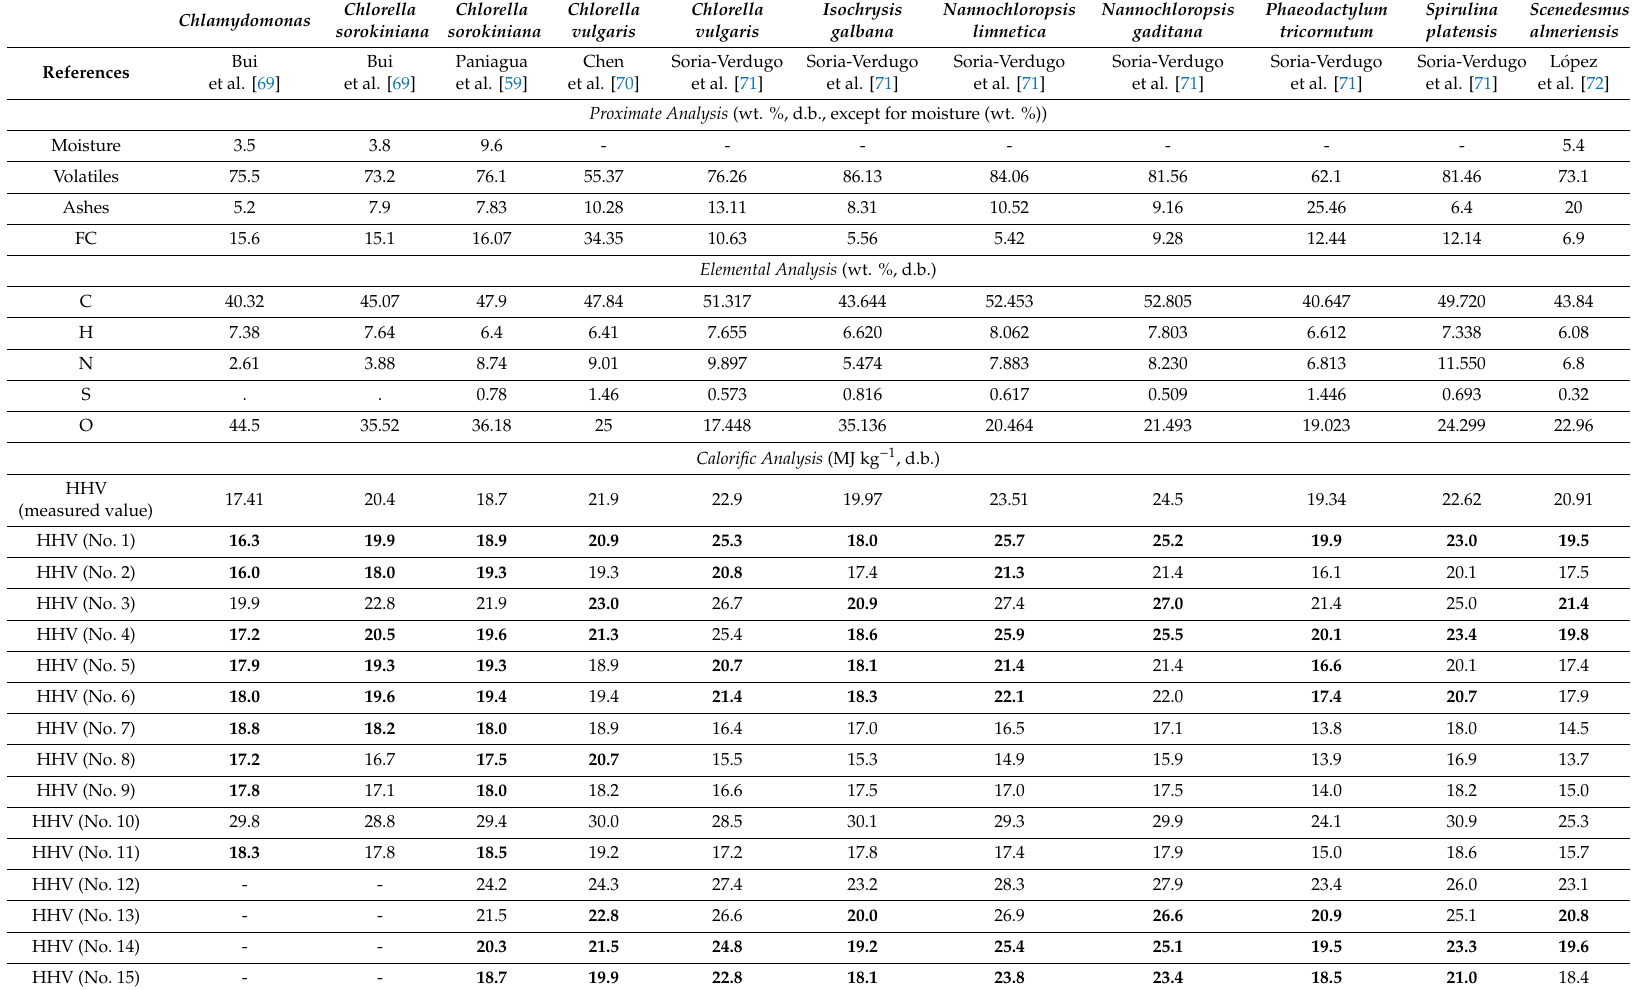
Table 4. Published results on the proximate, elemental and calorific analysis for di ff erent microalgae biomasses. For each case, the published High Heating Value (HHV) is shown together with the HHV estimated by correlations displayed in Table 1. Estimated HHVs that are within ± 10% the measured value are in